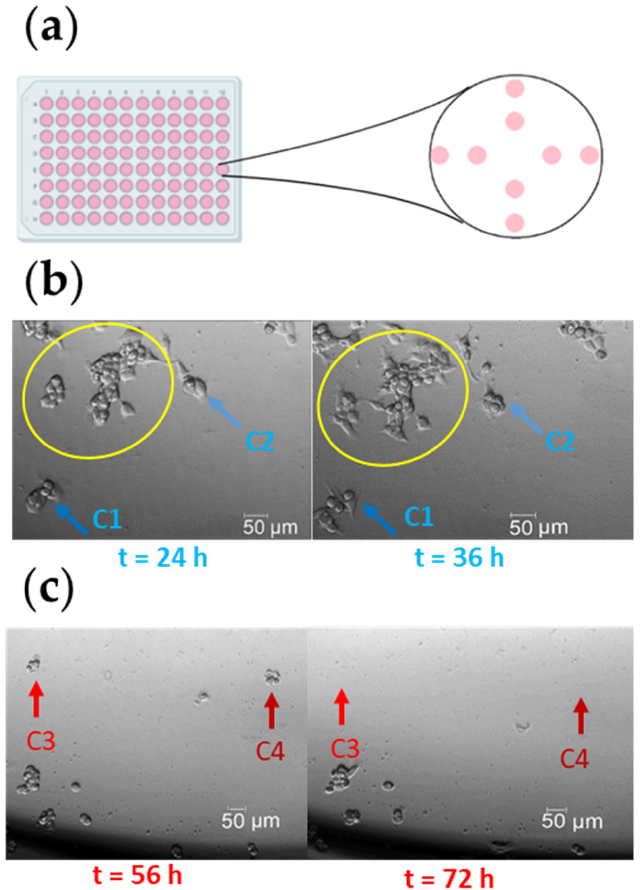
Figure 2. The experimental approach to classify viable or dead cells. ( a ) Schematic representation of cell seeding. ( b ) The clusters of cells marked with a yellow circle were excluded from the analysis. Cells marked with a blue arrow (dark blue arrow, C1; or light blue arrow, C2) were recorded at t = 24 h and t = 36 h for comparative analysis, to identify proliferating cells. These cells were classified as viable cells. ( c ) Cells marked with red arrows (light red arrow, C3; or dark red arrow, C4) were recorded at t = 56 h and t = 72 h for comparative analysis, to identify lysed cells. These cells were classified as dead cells.